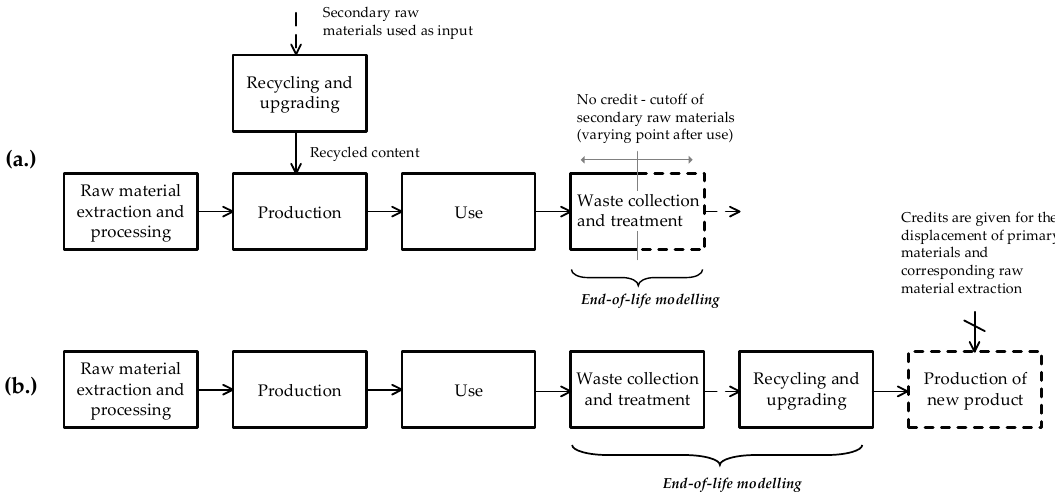
Figure 1. Illustration of ( a ) the cutoff approach, and ( b ) the end-of-life recycling approach. Boxes show processes, full arrows show material flows, broken arrows show scrap material flows, and crossed arrows show substituted material flows. In alternative ( a ), the position of the cutoff point may vary, and as a result, the scope of upstream “recycling and upgrading” varies correspondingly. Although not shown, upgrading generally requires some blending with primary materials.